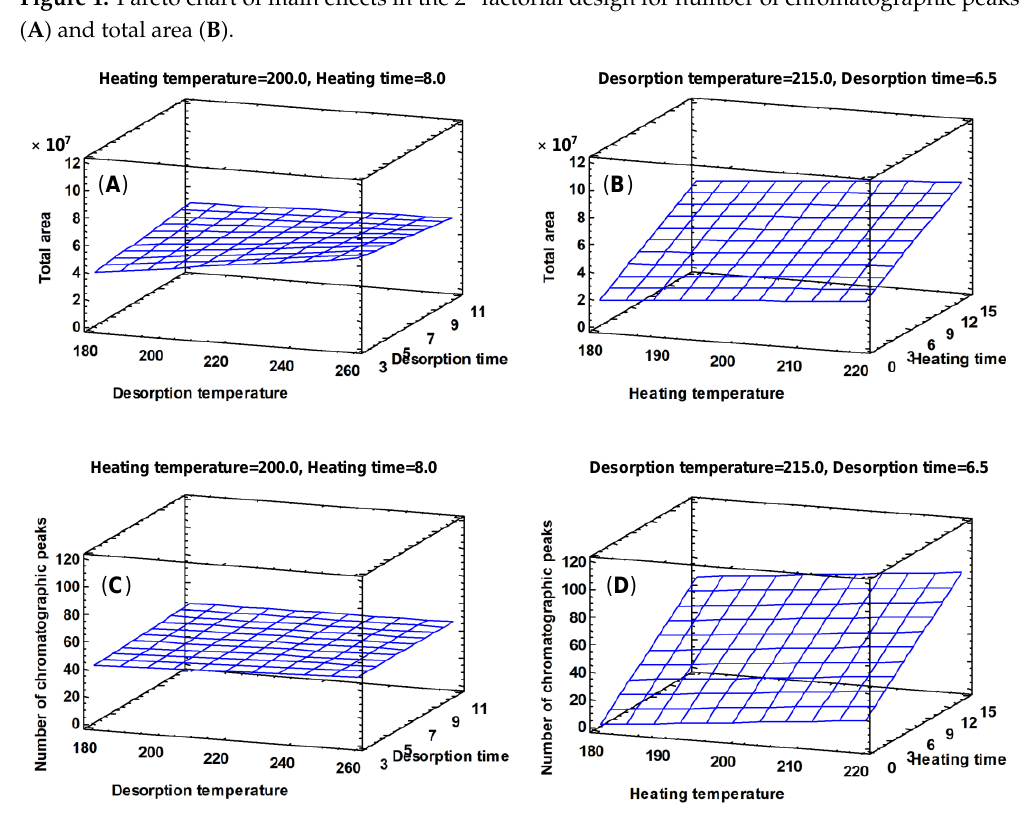
Figure 1. Pareto chart of main effects in the 2 4 factorial design for number of chromatographic peaks ( A ) and total area ( B ).